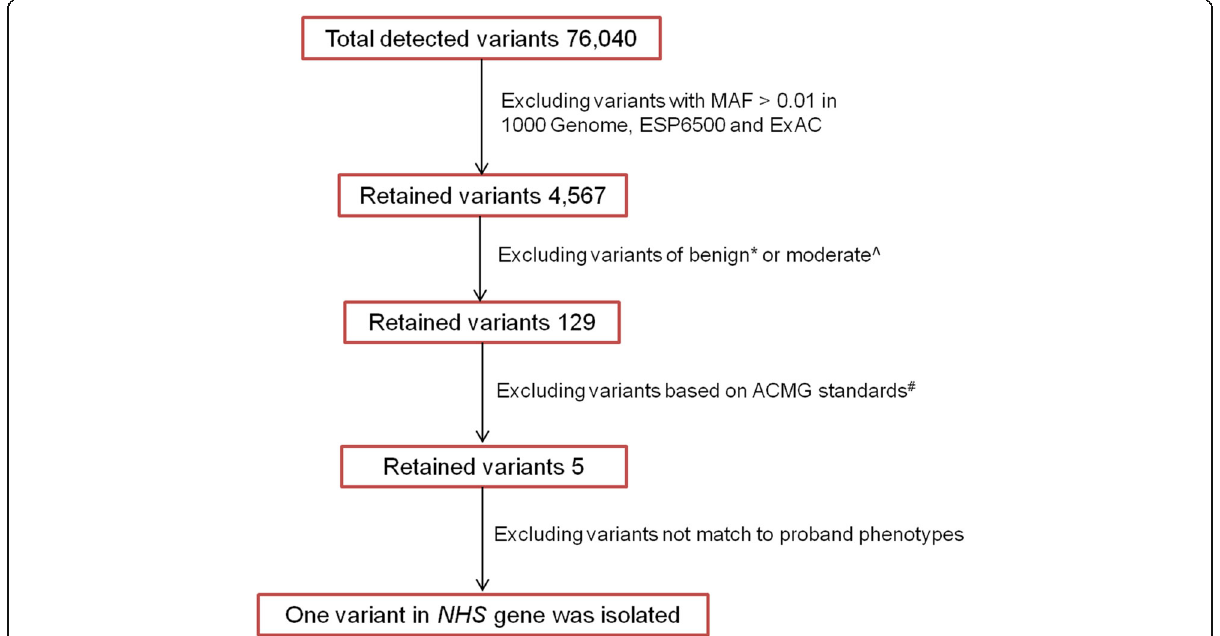
Fig. 3 Variant filter flow chart. To identify the underlying variant, we performed strict filter procedures. Benign*: variants occurred in the noncoding region and no prediction indicated pathogenic or likely pathogenic. Morderate^: variants occurred in the coding region, but no prediction implied pathogenic or likely pathogenicACMG standards: variants were classified with the rules of combining criteria of the ACMG guidelines, and 5 of the pathogenic variants were